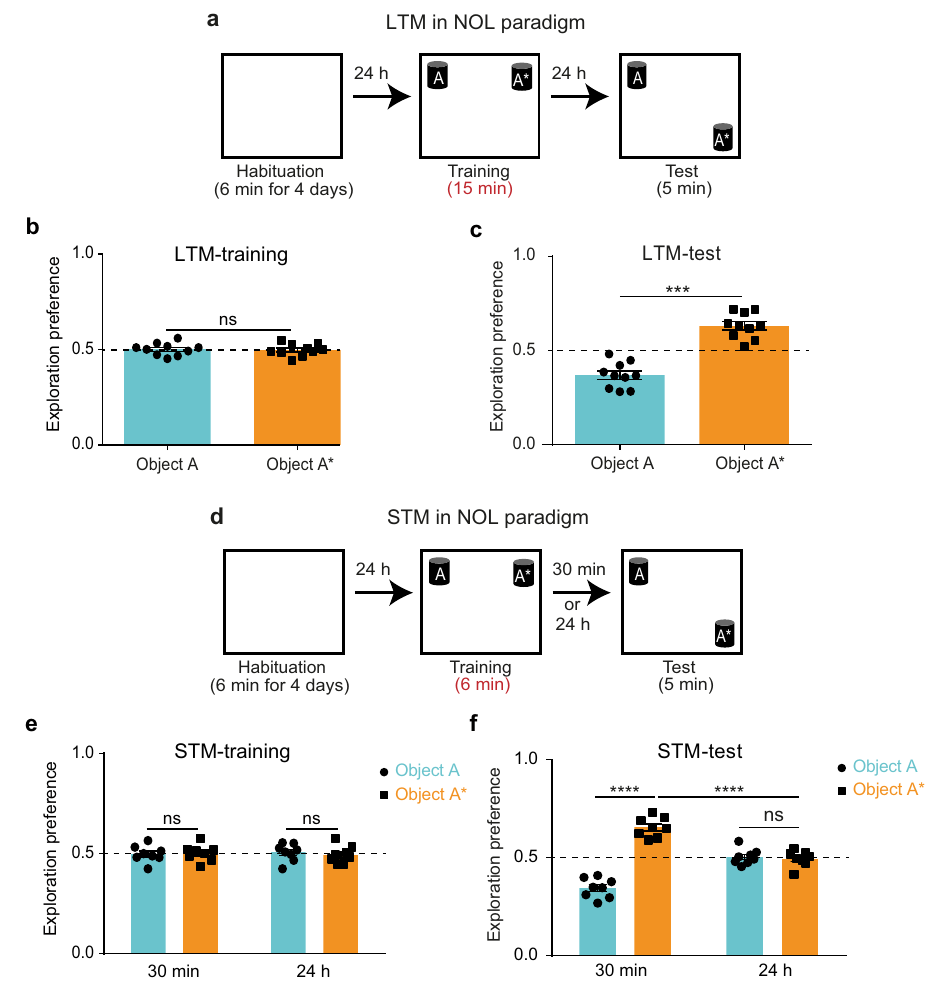
Fig. 1 LTM and STM in novel object location task (NOL). a NOL paradigm with the strong training protocol (15 min). Exploration preference for each object during the strong training ( b ) and the test sessions ( c ) ( n = 10). d NOL paradigm with the weak training protocol (6 min). Exploration preference for each object during the weak training ( e ) and the test sessions ( f ) for groups tested after 30 min ( n = 8) or 24 h ( n = 8). Comparisons were made using paired student ’ s t-test for comparing object A and object A* in the same group, and unpaired student ’ s t-test for comparing object A* within different groups; ns not signi fi cant ( P > 0.05), *** P < 0.001, **** P < 0.0001. Data are presented as the mean ±